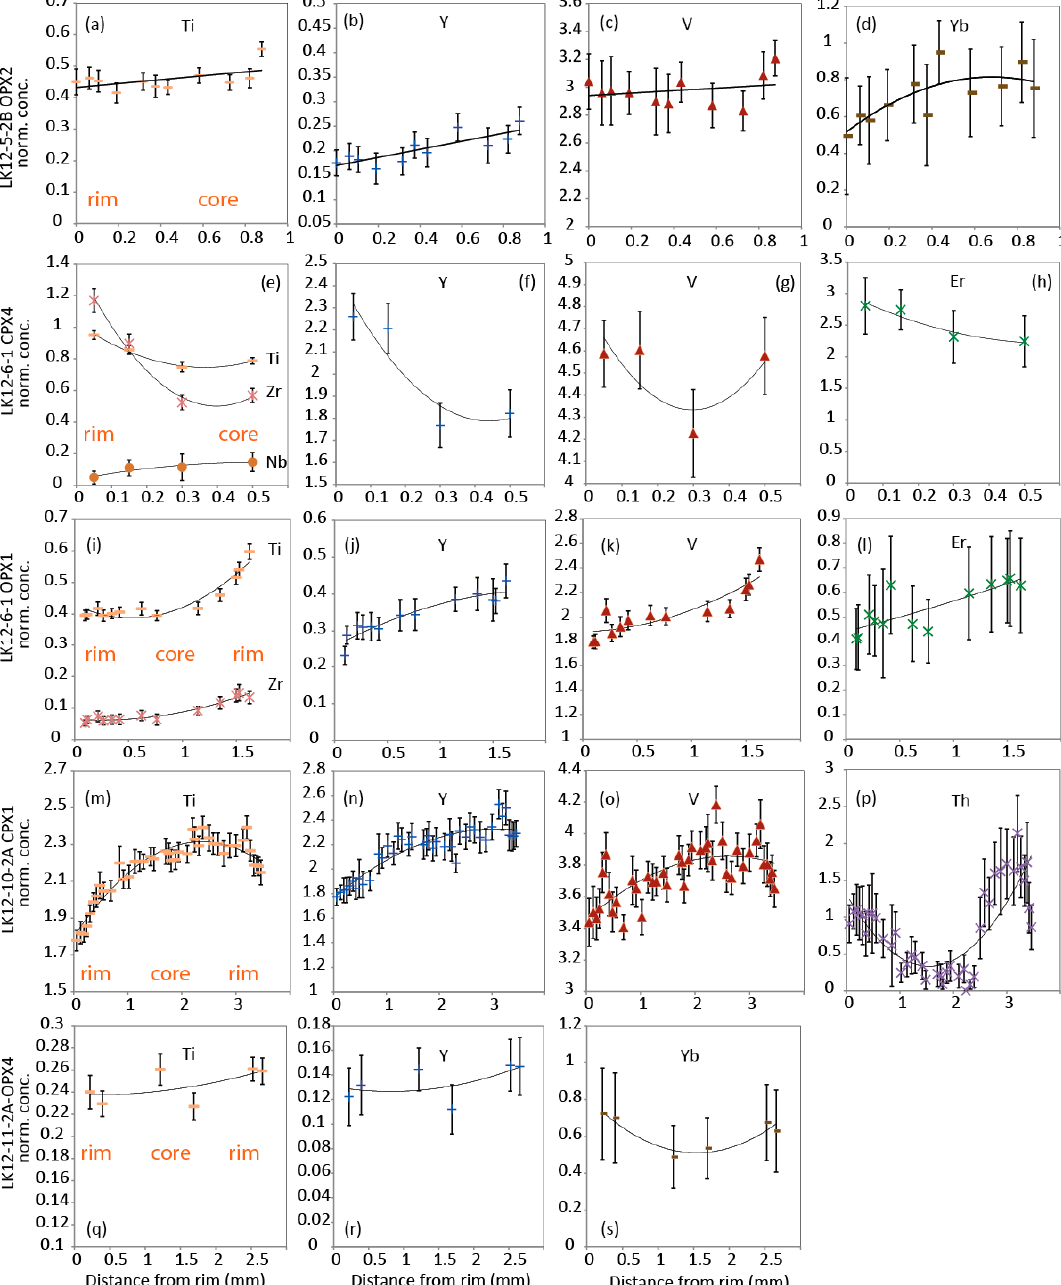
profile, LK12-6-1 is a 1 profile, 2 4